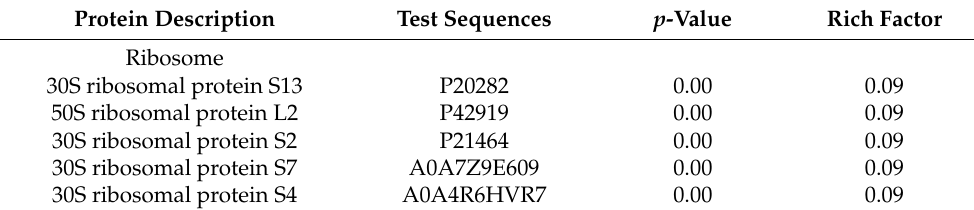
Table 4. The respective DEPs in B. subtilis spores after PT-LK treatment. Protein Description Test Sequences p -Value Rich Factor